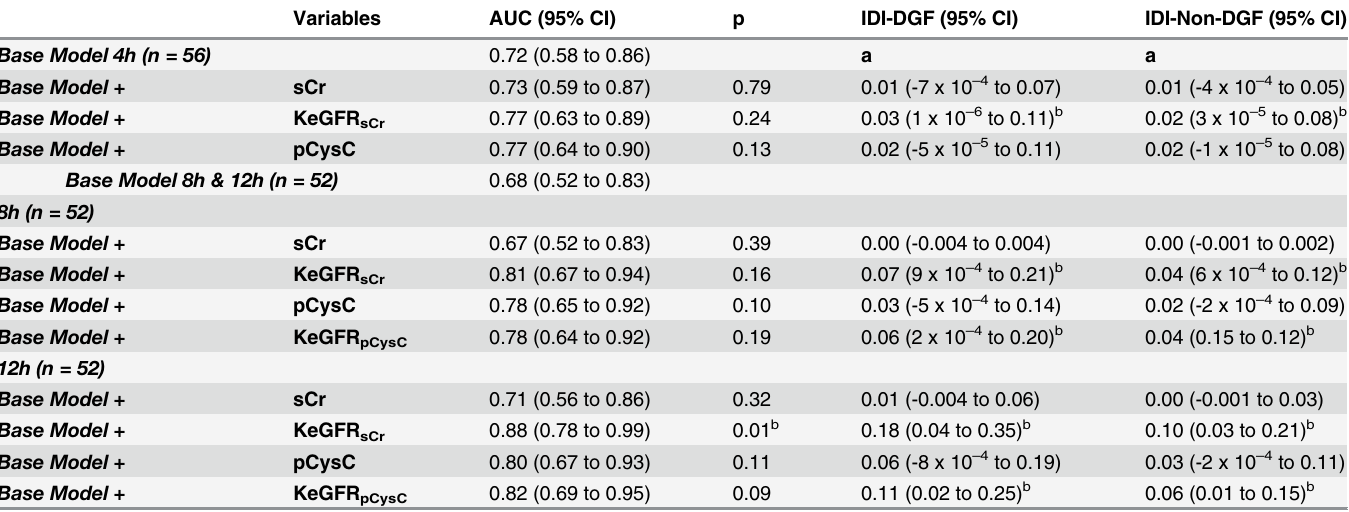
Table 2. Prediction of DGF using KeGFR versus the clinical